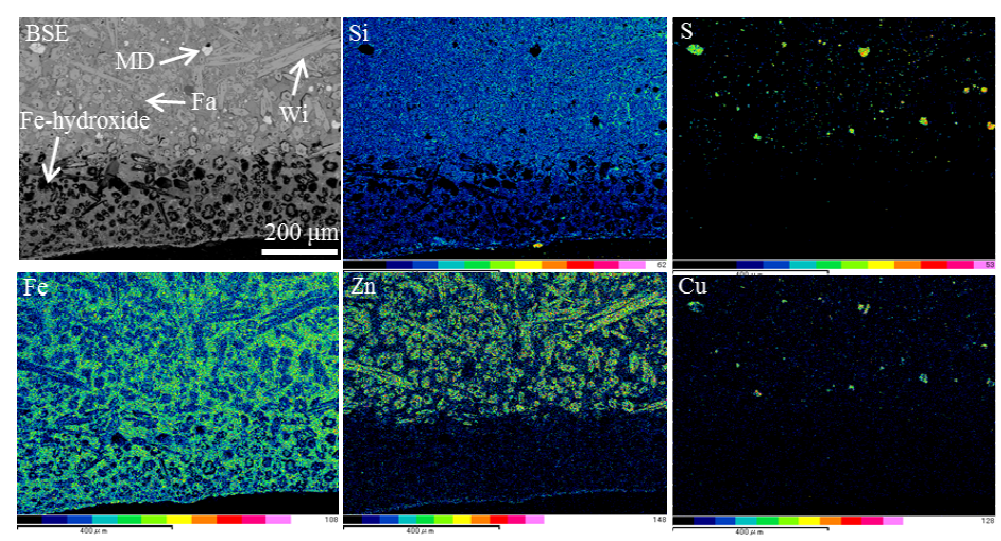
Figure 6. A back-scattered electron image and quantitative elemental maps